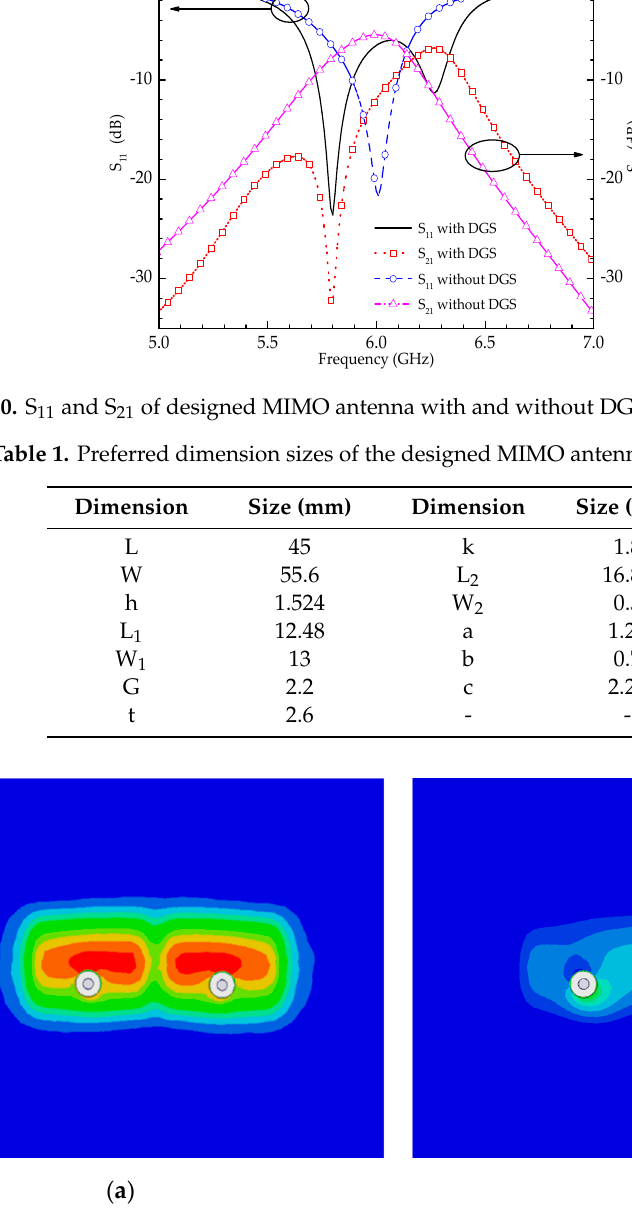
Figure 11. Current distribution of designed MIMO antenna T/2 (T is a phase period). ( a ) Without DGS; ( b ) With DGS, focus on 5.8 GHz.